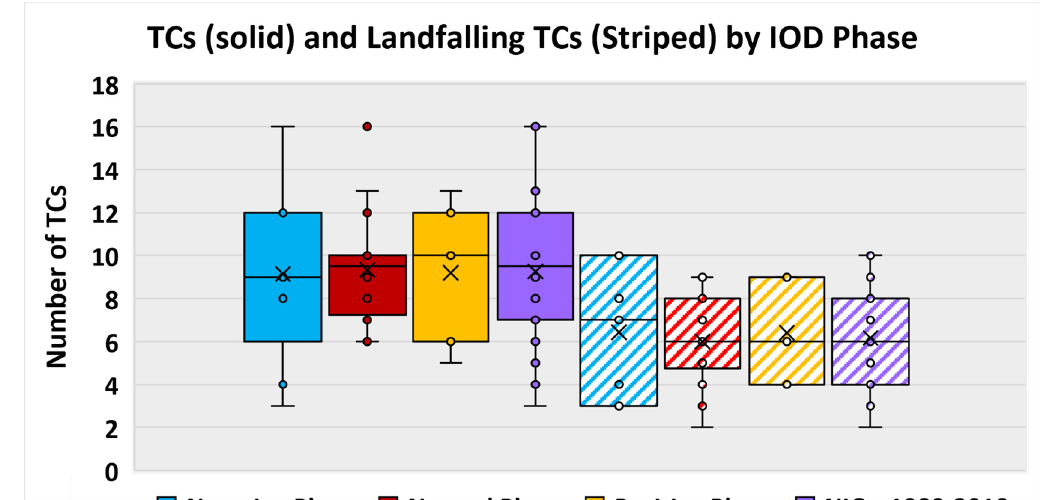
Figure 6. Box-and-whiskers plots of annual TC activity in the NIO region separated by the Indian Ocean Dipole (IOD) phase for all activity (solid) and landfalling activity (striped) for the negative phase (blue), neutral phase (red), positive phase (gold), and all TCs (purple). The mean is indicated by “x” and all data points are indicated by open circles.